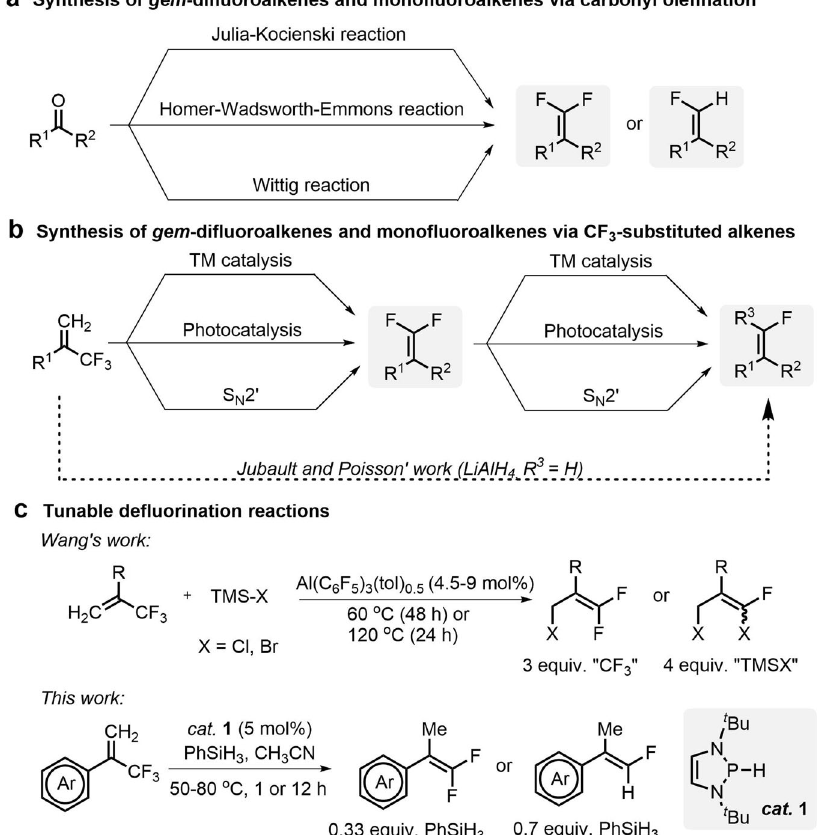
Fig. 2 State of the art strategies for synthesis of gem -di fl uoroalkenes and mono fl uoroalkenes and this work. a Synthesis of gem -di fl uoroalkenes and mono fl uoroalkenes via carbonyl ole fi nation. b Synthesis of gem -di fl uoroalkenes and mono fl uoroalkenes via CF 3 -substituted alkenes. c Tunable de fl uorination reactions.